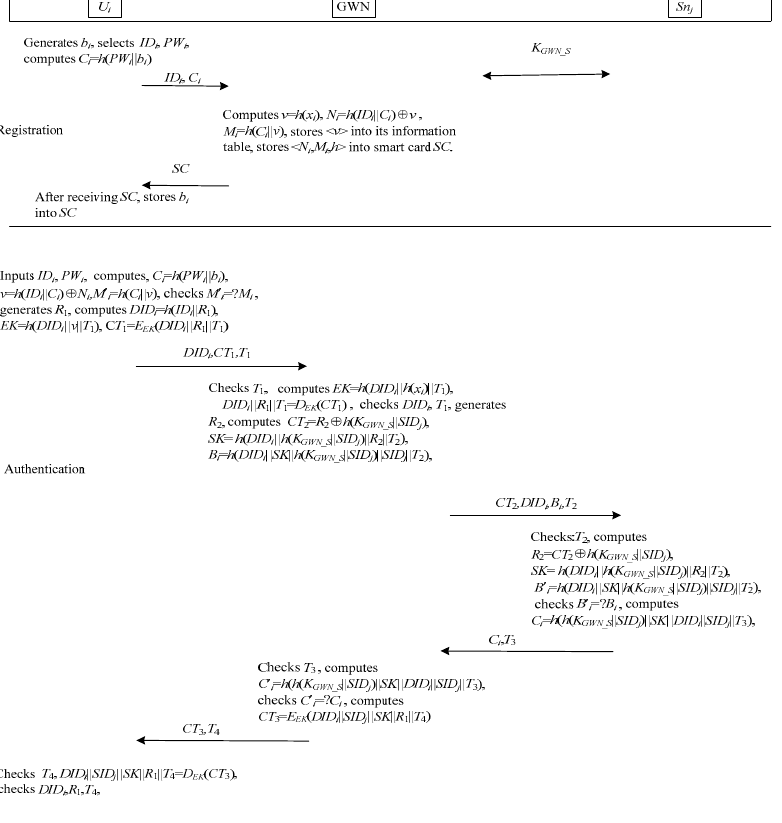
Figure 3. The authentication and key agreement phase of Jung et al.’s scheme.